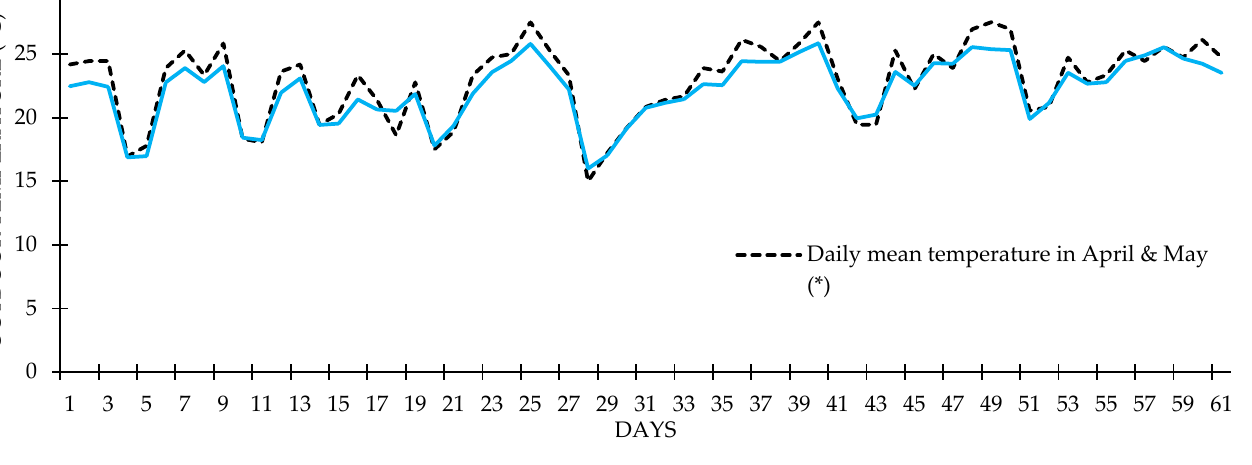
Figure 3. Daily mean temperature vs. measured temperature from observation station. (*) Data from National Weather Service, U.S. Dept. of Commerce [30].